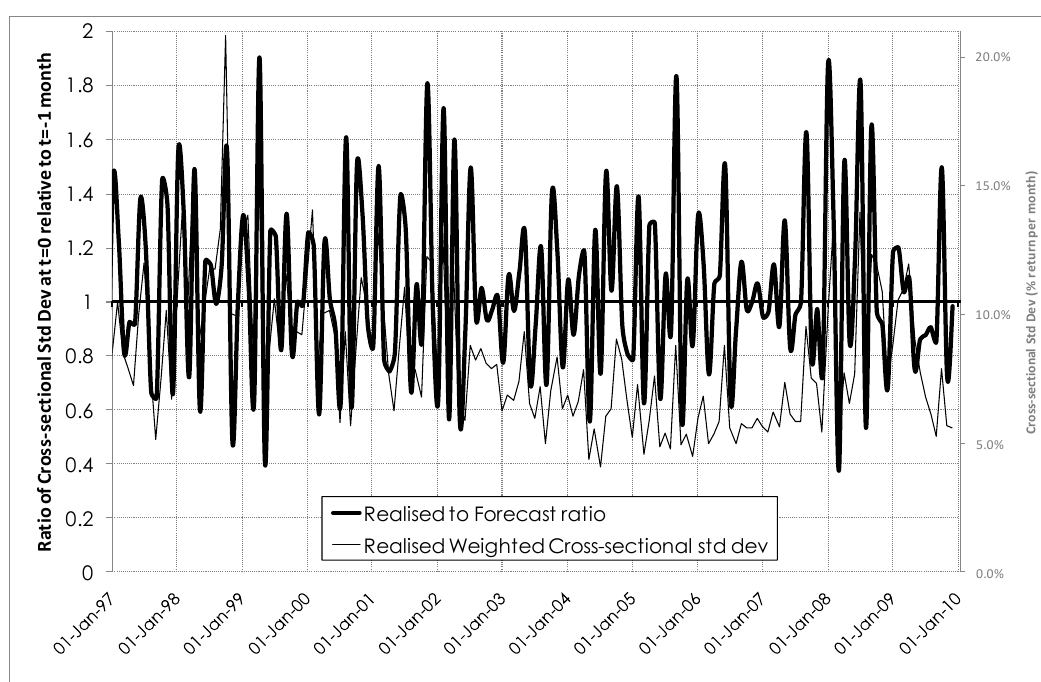
Figure 1: Ratio of realised cross-sectional standard deviation to its one month lag